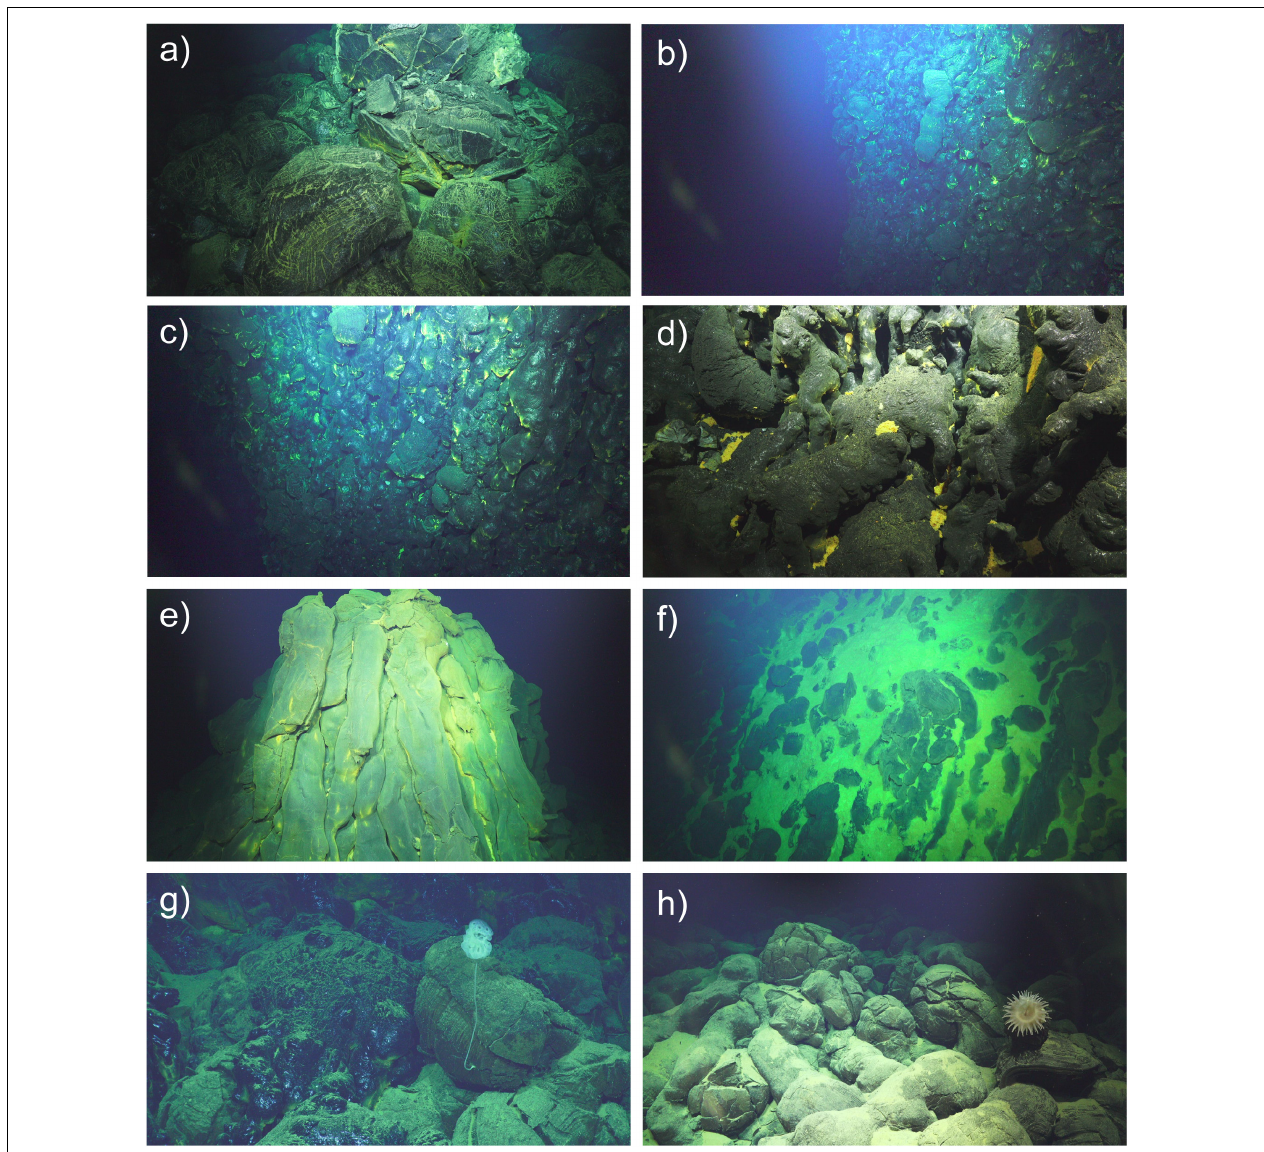
FIGURE 11 | Images from ROV SuBastian dive S45 on 12 December 2016. See Figure 10 for photo locations. Numbers in parentheses are time of photo in GMT and horizontal scale. (a) Young pillow lava at the top of a mound at the beginning of the dive (01:31:24, 4 m). (b) Nearly vertical cliff mantled by intact young pillow lavas (01:47:42, 15 m). (c) Glassy narrow pillow tubes on the cliff face (01:48:26, 12 m). (d) Close up of glassy pillow buds about mid-way down the cliff face (01:57:36, 2 m). (e) Pillow cone atop a low pillow mound dusted with yellow hydrothermal sediment (02:14:58, 8 m). (f) Locally thick accumulation of hydrothermal sediment on a young pillow mound (02:21:05, 10 m). (g) Western contact of the young lavas (glassy in upper left) with surrounding older lavas (with sponge attached at lower right) (04:19:45, 5 m). (h) Surrounding older lavas with anemone attached (04:22:14, 5